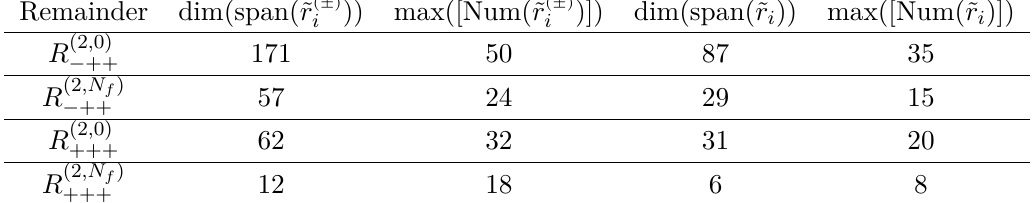
Table 1 . Improvements in the number of basis functions and in the mass dimension of the numerators with known factors pulled out when moving from a basis ˜ r ( ± ) mixed